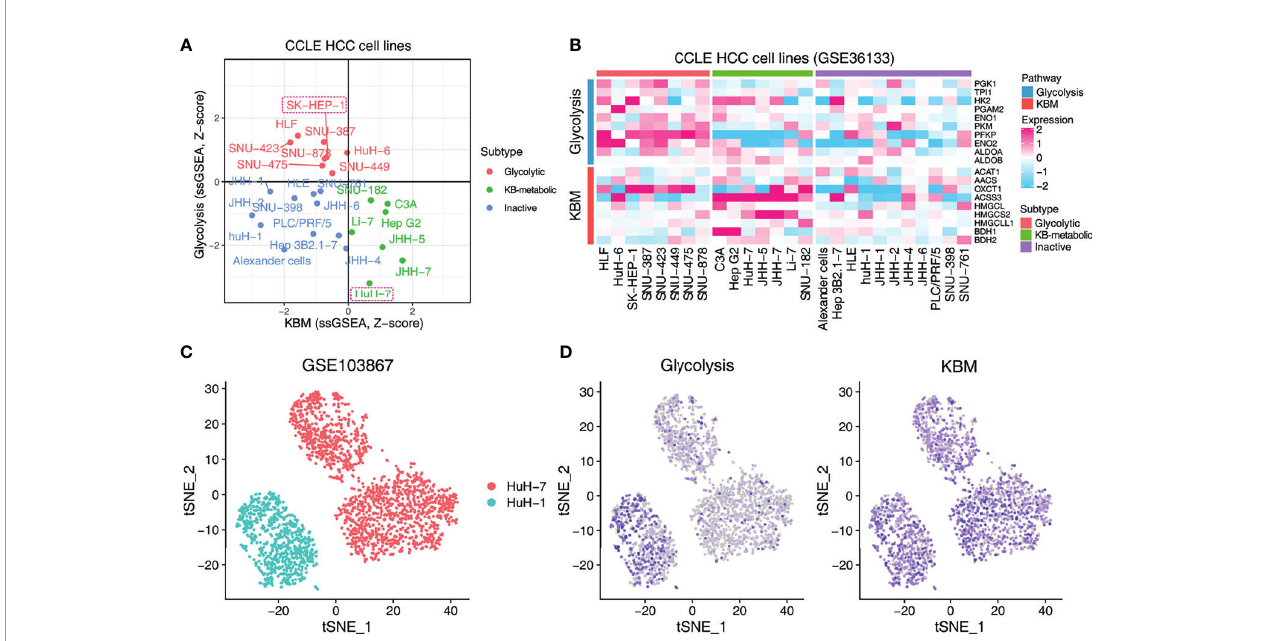
FIGURE 6 | Exploring the metabolic subtypes in HCC cell lines. (A) Scatter plot showing the subtype of CCLE HCC cell lines. Red indicates glycolytic subtype, and green indicates KB-metabolic subtype. The cell lines in the dashed boxes were chosen for the following experiment. (B) Heatmap showing the expression pattern of glycolysis and KBM genes of CCLE HCC cell lines with different subtypes. (C) t-SNE plot of HuH-1 and HuH-7 from GSE103867 dataset. (D) The pathway activity of glycolysis and KBM represented by ssGSEA score in t-SNE space from cells in (C)